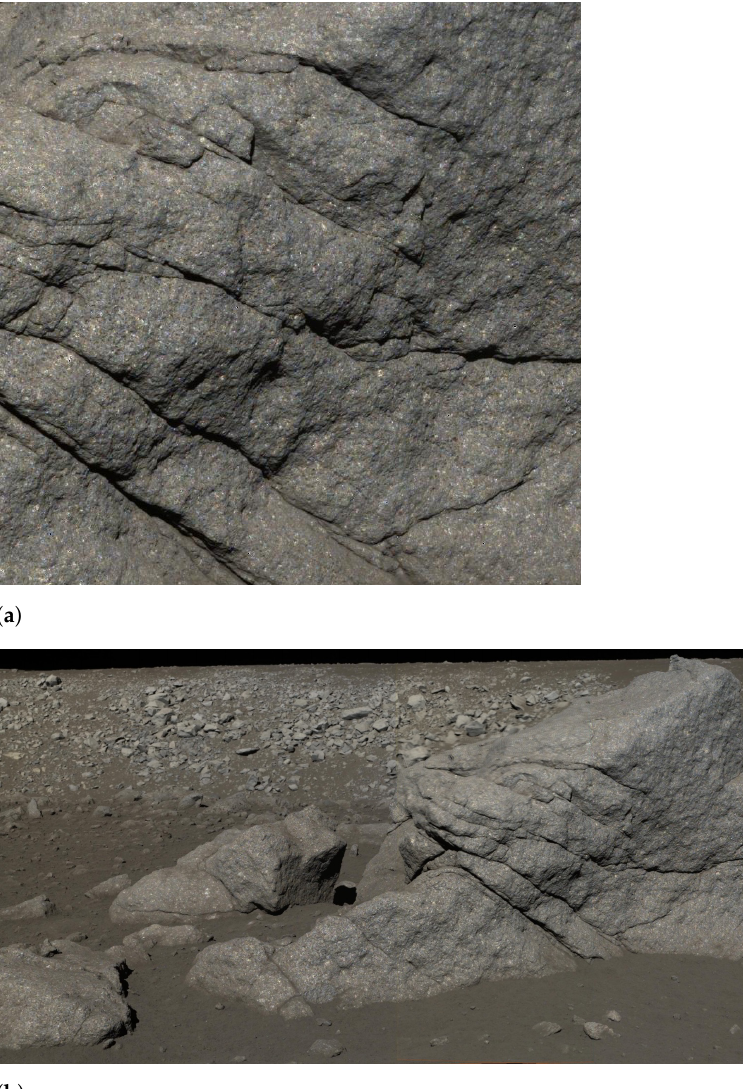
Figure 13. The CE-3 rover captured image of the Loong Rock, which is located ~11 m away from the soil sample LS2, displaying its detailed morphology in subfigure ( a ) and panoramic view in subfigure ( b ). These images were obtained by the PCAMs mounted on the mast on- board the Yutu rover at (44.11864 ◦ N, 19.50996 ◦ W). The data IDs for the images are provided as follows: CE3_BMYK_PCAML-C-012_SCI_N_20140113191206_20140113191206_0008_A.2C and